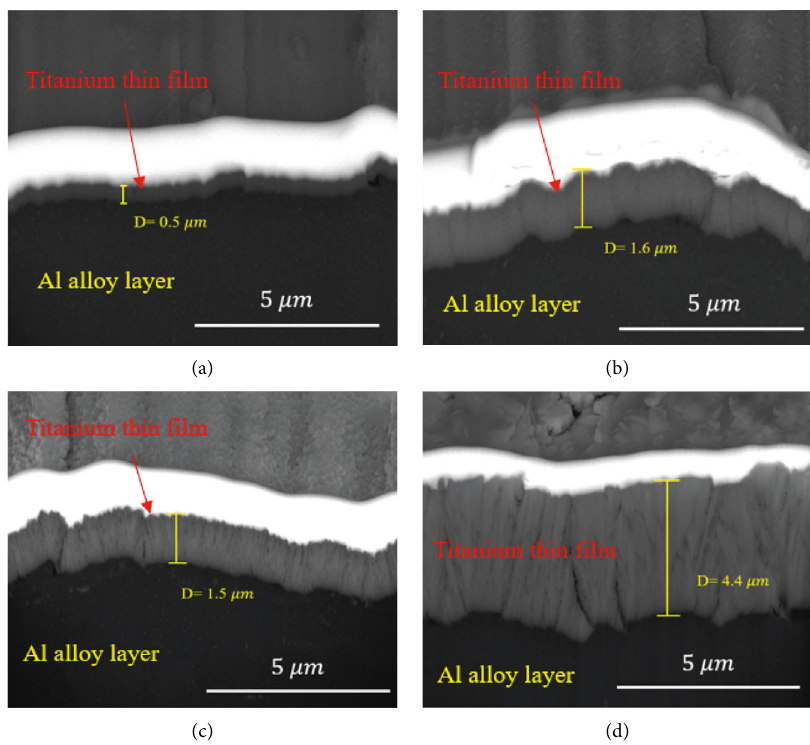
Figure 2: SEM image of cross-sectional view: (a) 30min 100W; (b) 90min 100W; (c) 30min 300W; (d) 90min 300W.